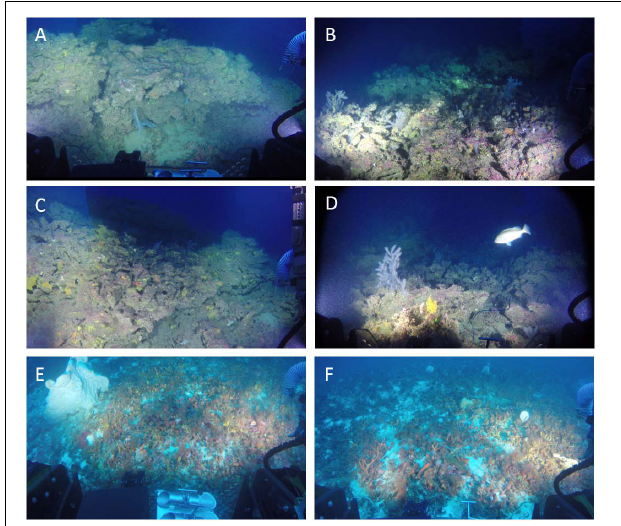
FIGURE 11 | Underwater images (A–D) are images from the shelf-edge reef in S3; images (E,F) show the rhodolith beds and associated mesophotic community along the mid-outer shelf classes in S1. Photographs taken from a